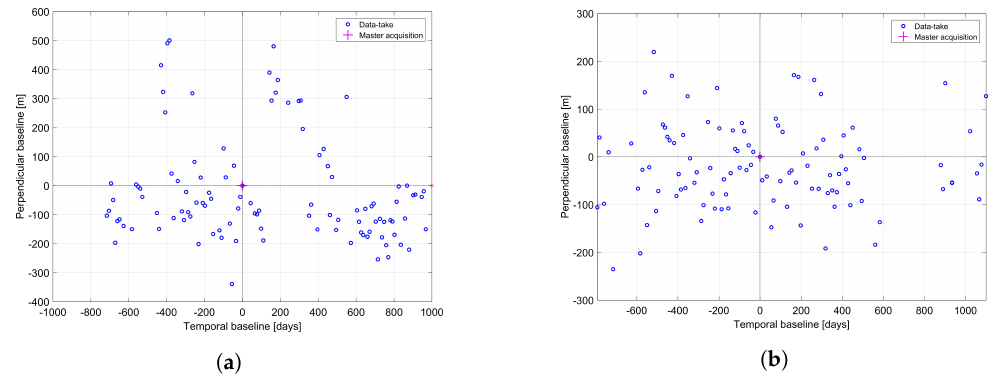
Figure 6. Temporal-perpendicular baseline distribution of the SAR image stacks in Berlin. ( a , b ) correspond to the data stacks of Beam57 and Beam42,